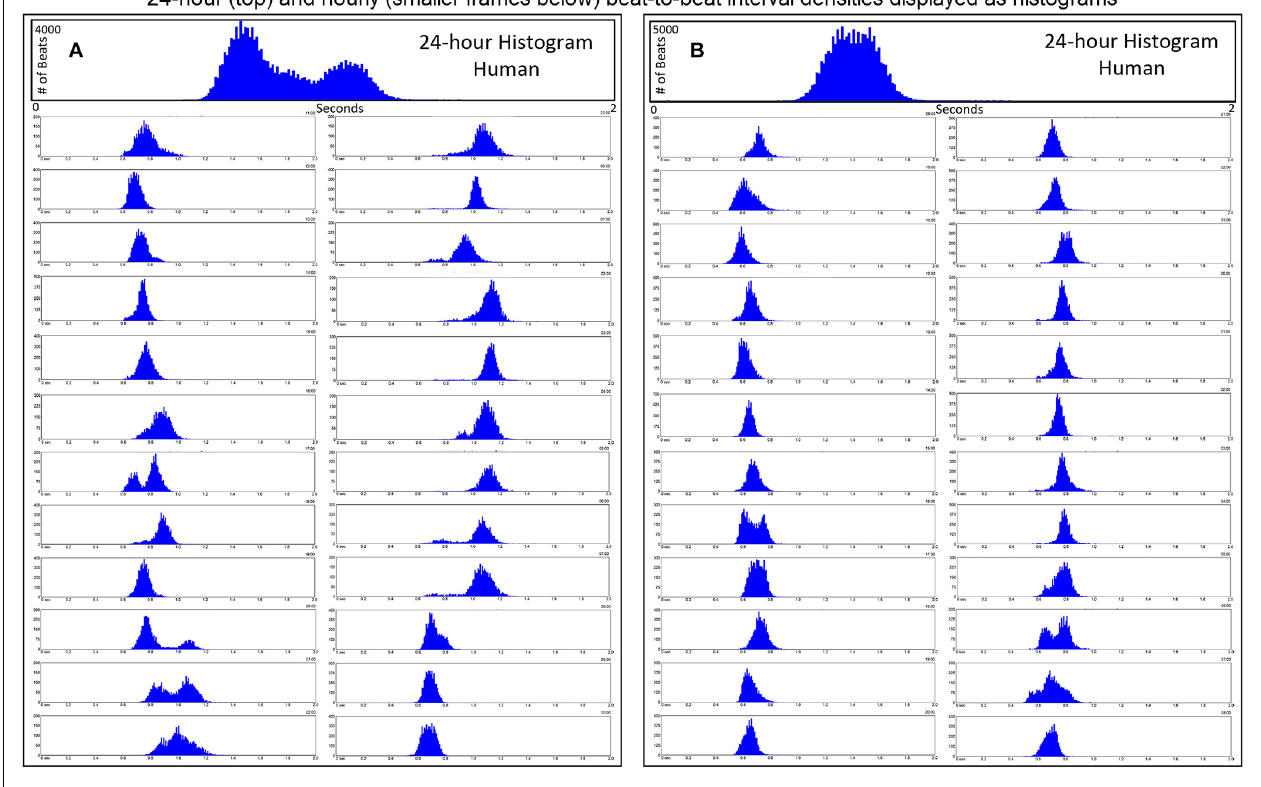
FIGURE 2 | R–R interval histograms from 24-h ECG recordings from two different humans. All of the human R–R interval histograms were either similar to these two individuals or a mixture of these two types of distributions. The top expanded frame is the summation of all R–R intervals over the 24 h. Note the different density distribution of R–R intervals (thus, heart rates) in these two individuals. The individual in frame (A) has more time at longer R–R intervals compared to the individual in frame (B) . Below the 24-h summary frames the corresponding 1-h histograms for each individual are shown. The summation of these 24 single 1-h histograms form the composite shown at the top for each individual. In general, depending on physiologic needs, the heart rate over a 1-h period primarily has a Gaussian-shaped distribution. Some hours have more than one Gaussian-shaped distribution. This type of distribution exists likely because the heart rate decreases and increases